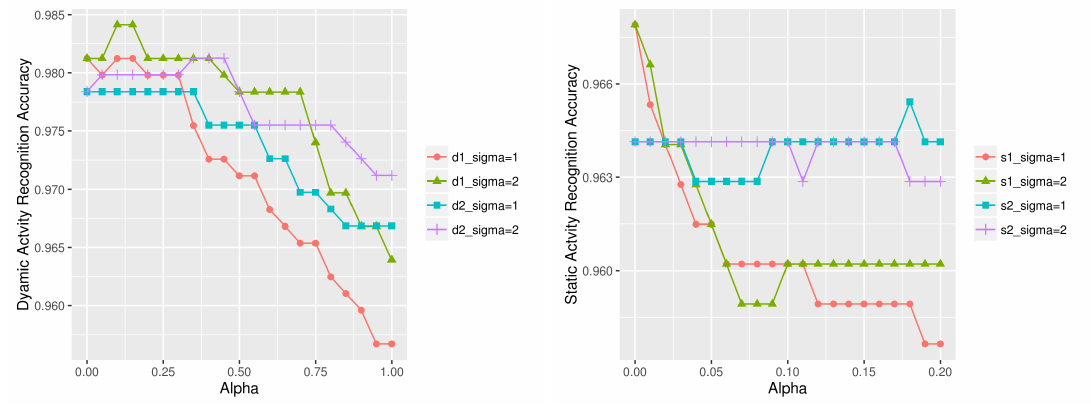
Figure 19. Dynamic ( a ) and static ( b ) activity recognition result using σ = 1,2 on UCI HAR